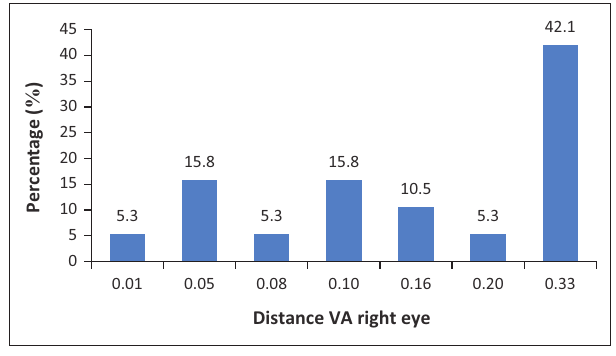
FIGURE 1: Distance visual acuity of the right eye recorded in decimal notation.